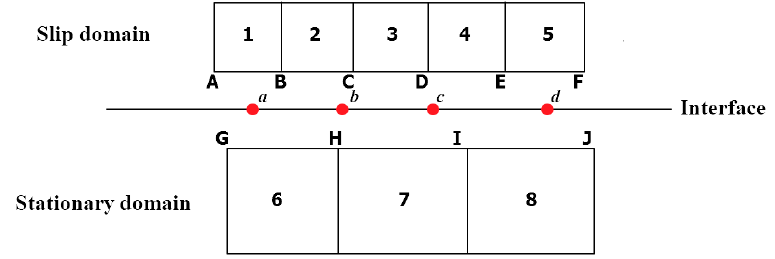
Figure 4. Sketch map of the sliding mesh. Figure 3. Sketch map of the sliding mesh.